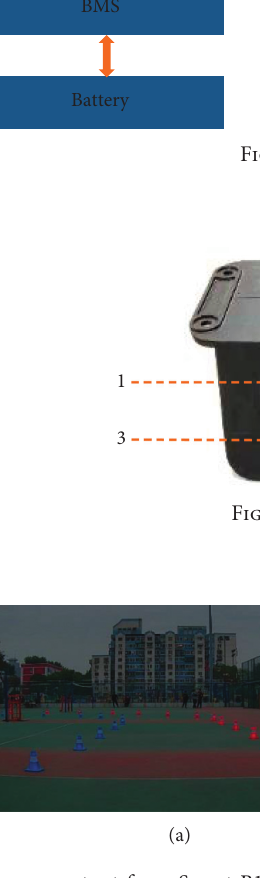
Figure 4: Images output from Smart B1 camera system. (a) The color image. (b) The processed depth image.